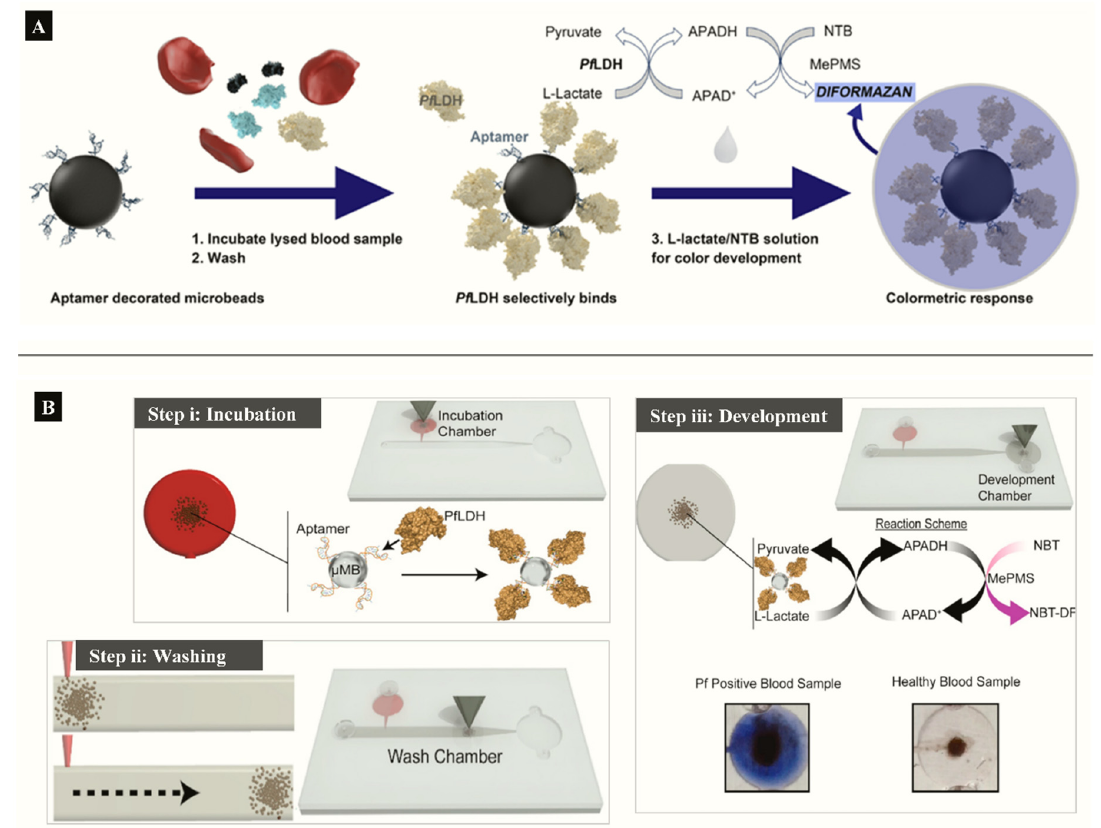
Figure 4. ( A ) APTEC biosensor based on capturing PfLDH and using its enzymatic activity to produce a colorimetric assay (Reprinted from Dirkzwager et al. [63] with permission from the American Chemical Society). ( B ) Working principle (( i ) incubation, ( ii ) washing ( ii ) and ( iii ) color development) of a